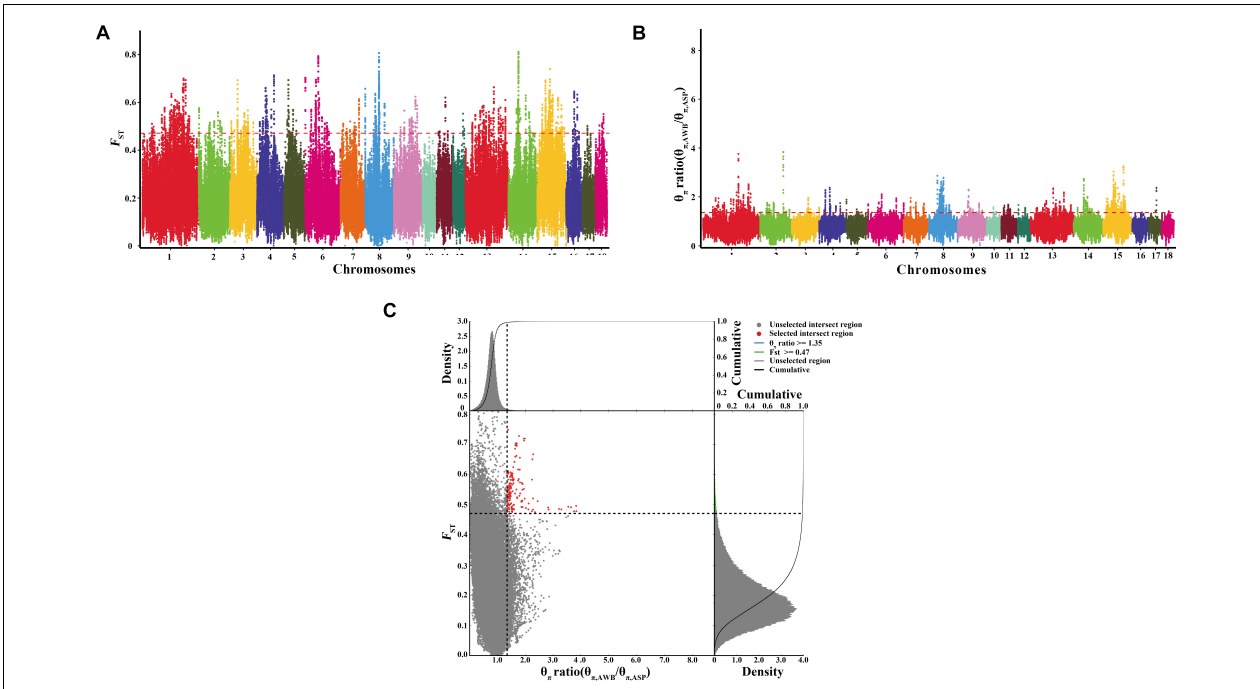
FIGURE 4 | Identification of genomic regions with strong selective sweep signals in Anqing six-end-white pig population. Distribution of θπ ratio ( θ π , AWB / θ π , ASP ) and F ST , which are calculated in 100-kb windows sliding in 10-kb steps. (A) Distribution of F ST values among autosome chromosomes. The red line represents the 0.01 level. (B) Distribution of θπ ratio among autosomal chromosomes. The red line represents the 0.01 level. (C) The final selection regions based on two statistics. Points located to the right of the vertical dashed lines (corresponding to 1% right tails of the empirical θπ ratio distribution, where θπ ratio is 1.352358) and above the horizontal dashed line (1% above tail of the empirical F ST distribution, where F ST is 0.470988) were identified as selected regions for Anqing s ix-end-white pig (ASP) (red